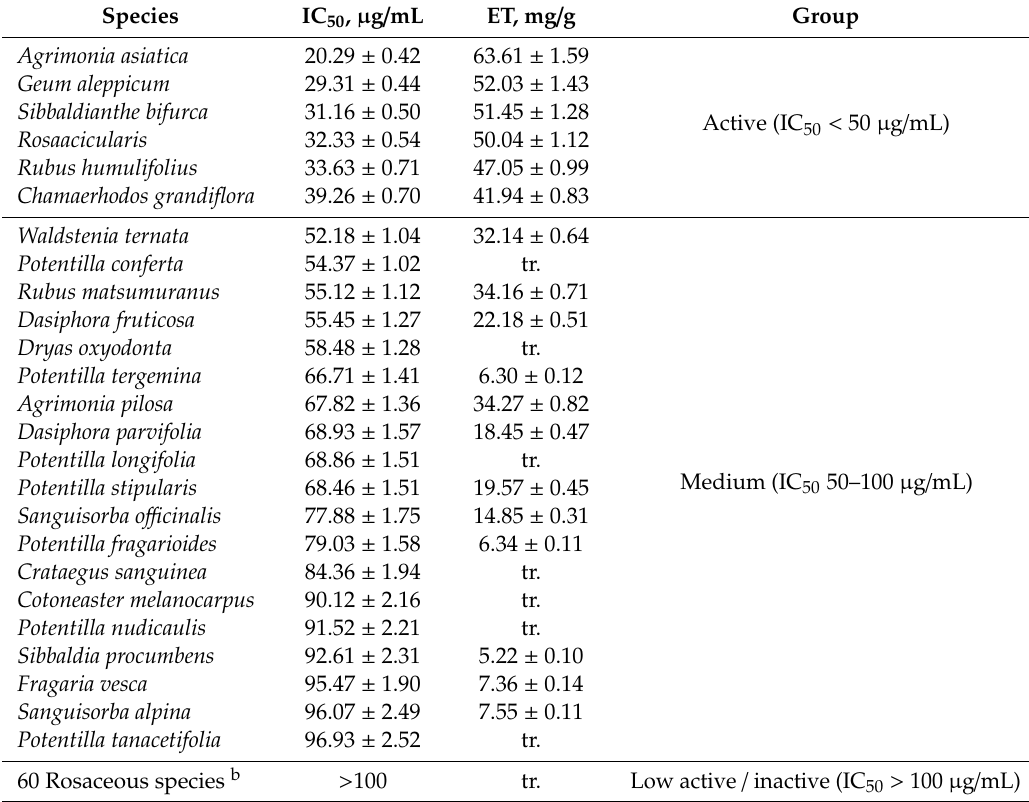
Table 1. α -Glucosidase inhibiting activity (IC 50 , µ g / mL ± S.D.)* and ellagitannin content (ET, mg / g of dry extract weight ± S.D.) for extracts from 85 Rosaceous tea